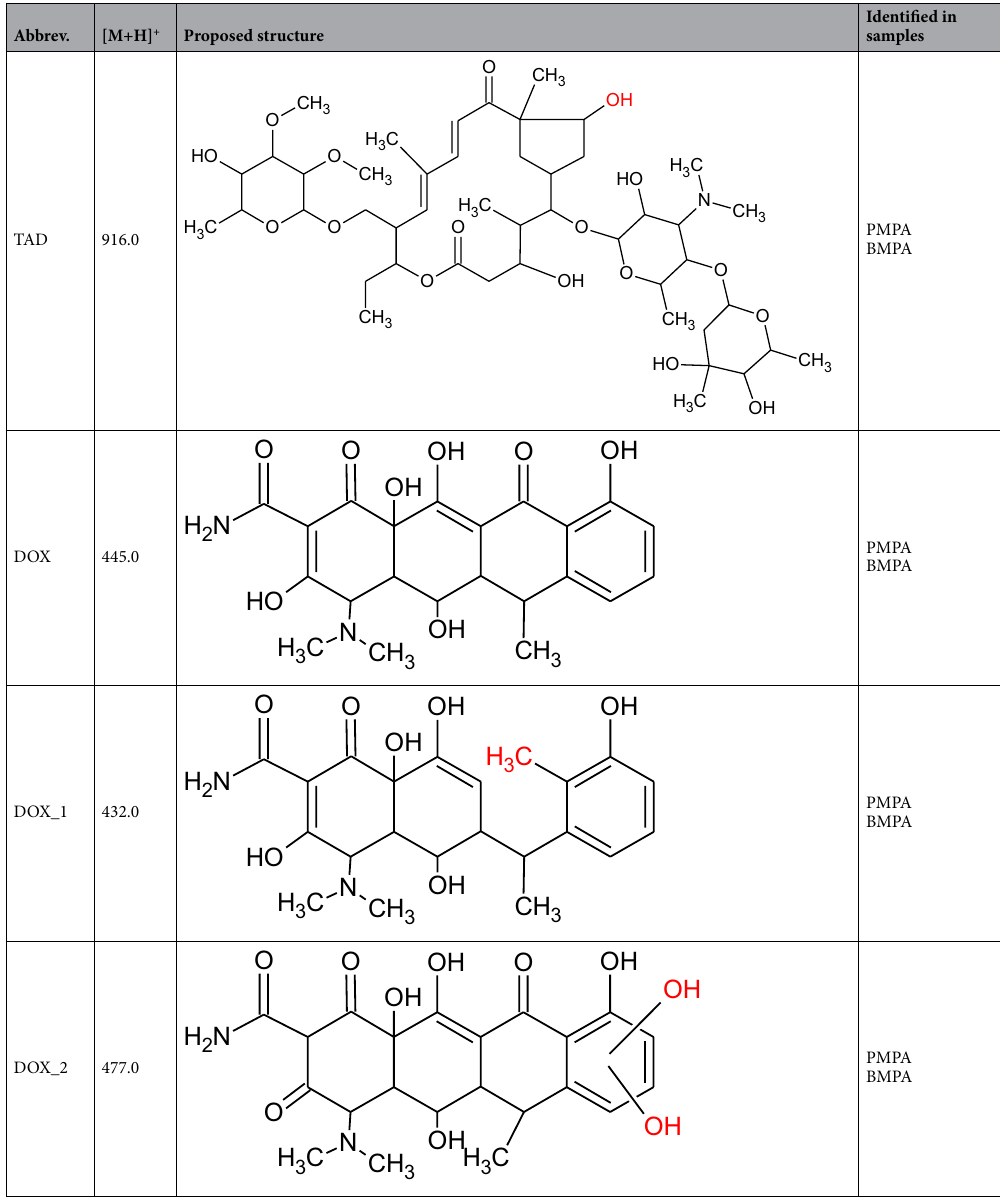
Table 4. Proposed structures of TPs of selected antimicrobials. PMPA—soil plots supplemented with poultry manure and antimicrobials; BMPA—soil plots supplemented with bovine manure and antimicrobials; PMP— poultry manure soil plots; BMP—bovine manure soil plots; CP—control plots without supplementation (manure or